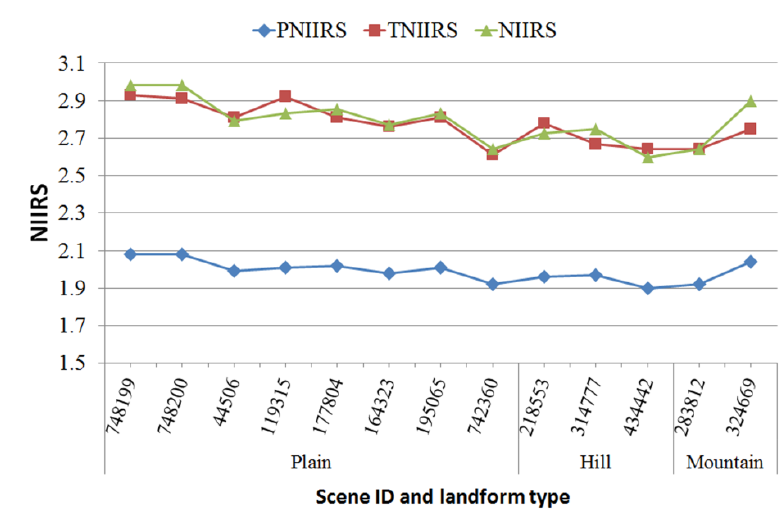
Figure 6. Results of the ONIIRS, PNIIRS and NIIRS